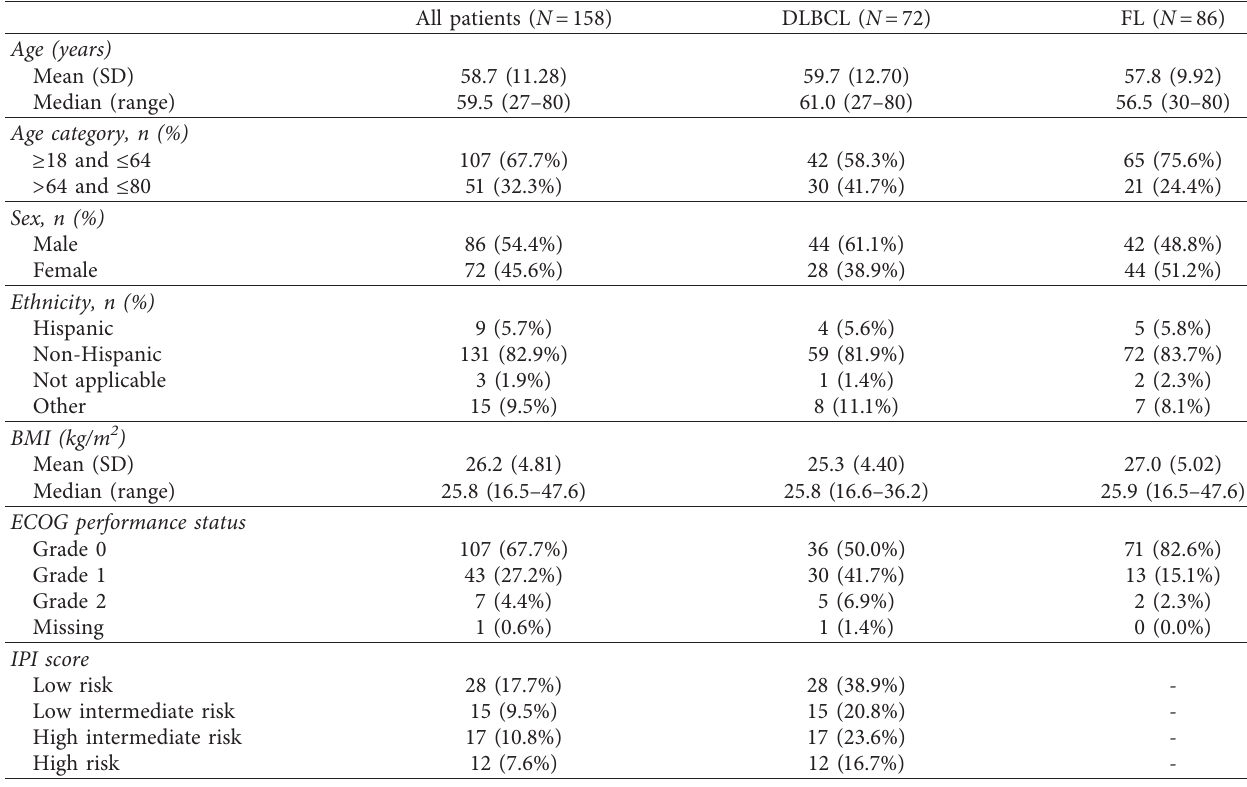
Table 2: Demographic and baseline characteristics of